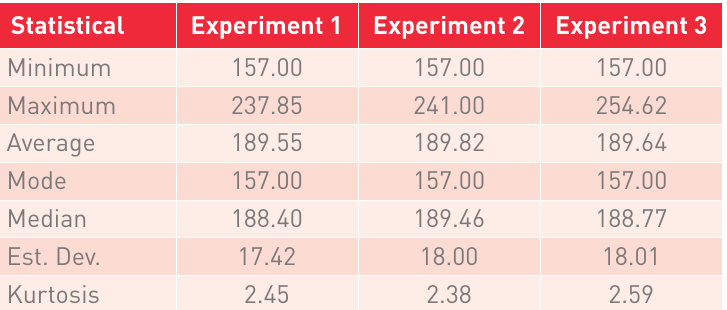
Statistical results of the